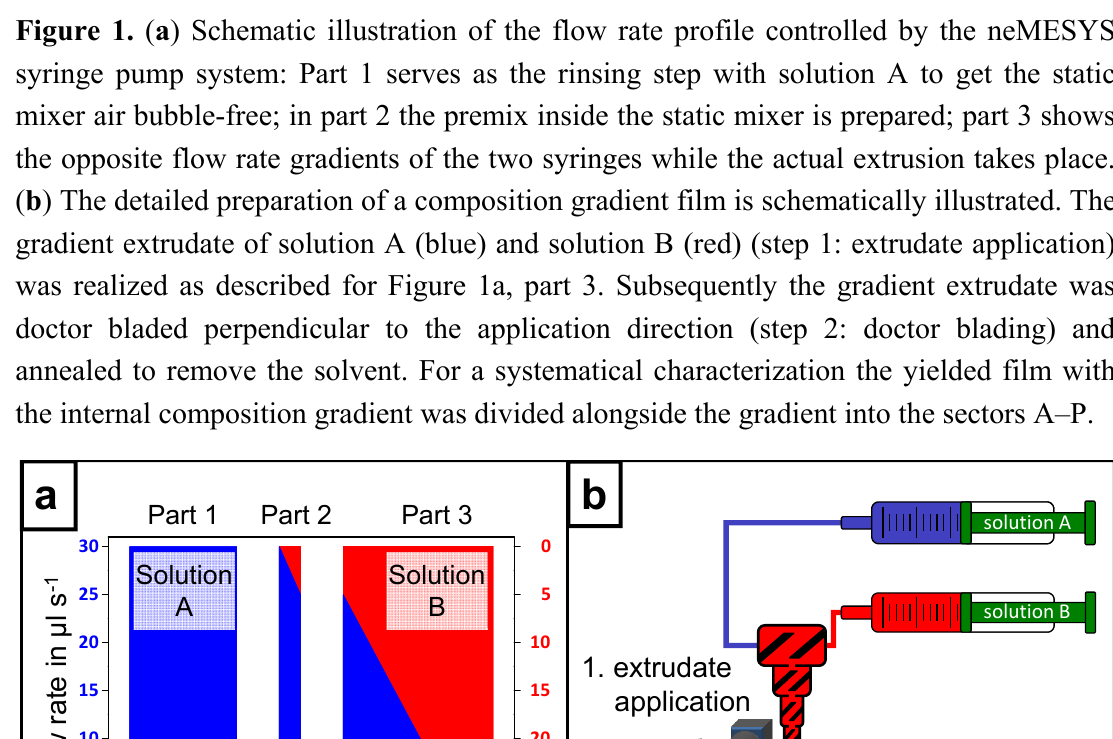
Figure 1. ( a ) Schematic illustration of the flow rate profile controlled by the neMESYS syringe pump system: Part 1 serves as the rinsing step with solution A to get the static mixer air bubble-free; in part 2 the premix inside the static mixer is prepared; part 3 shows the opposite flow rate gradients of the two syringes while the actual extrusion takes